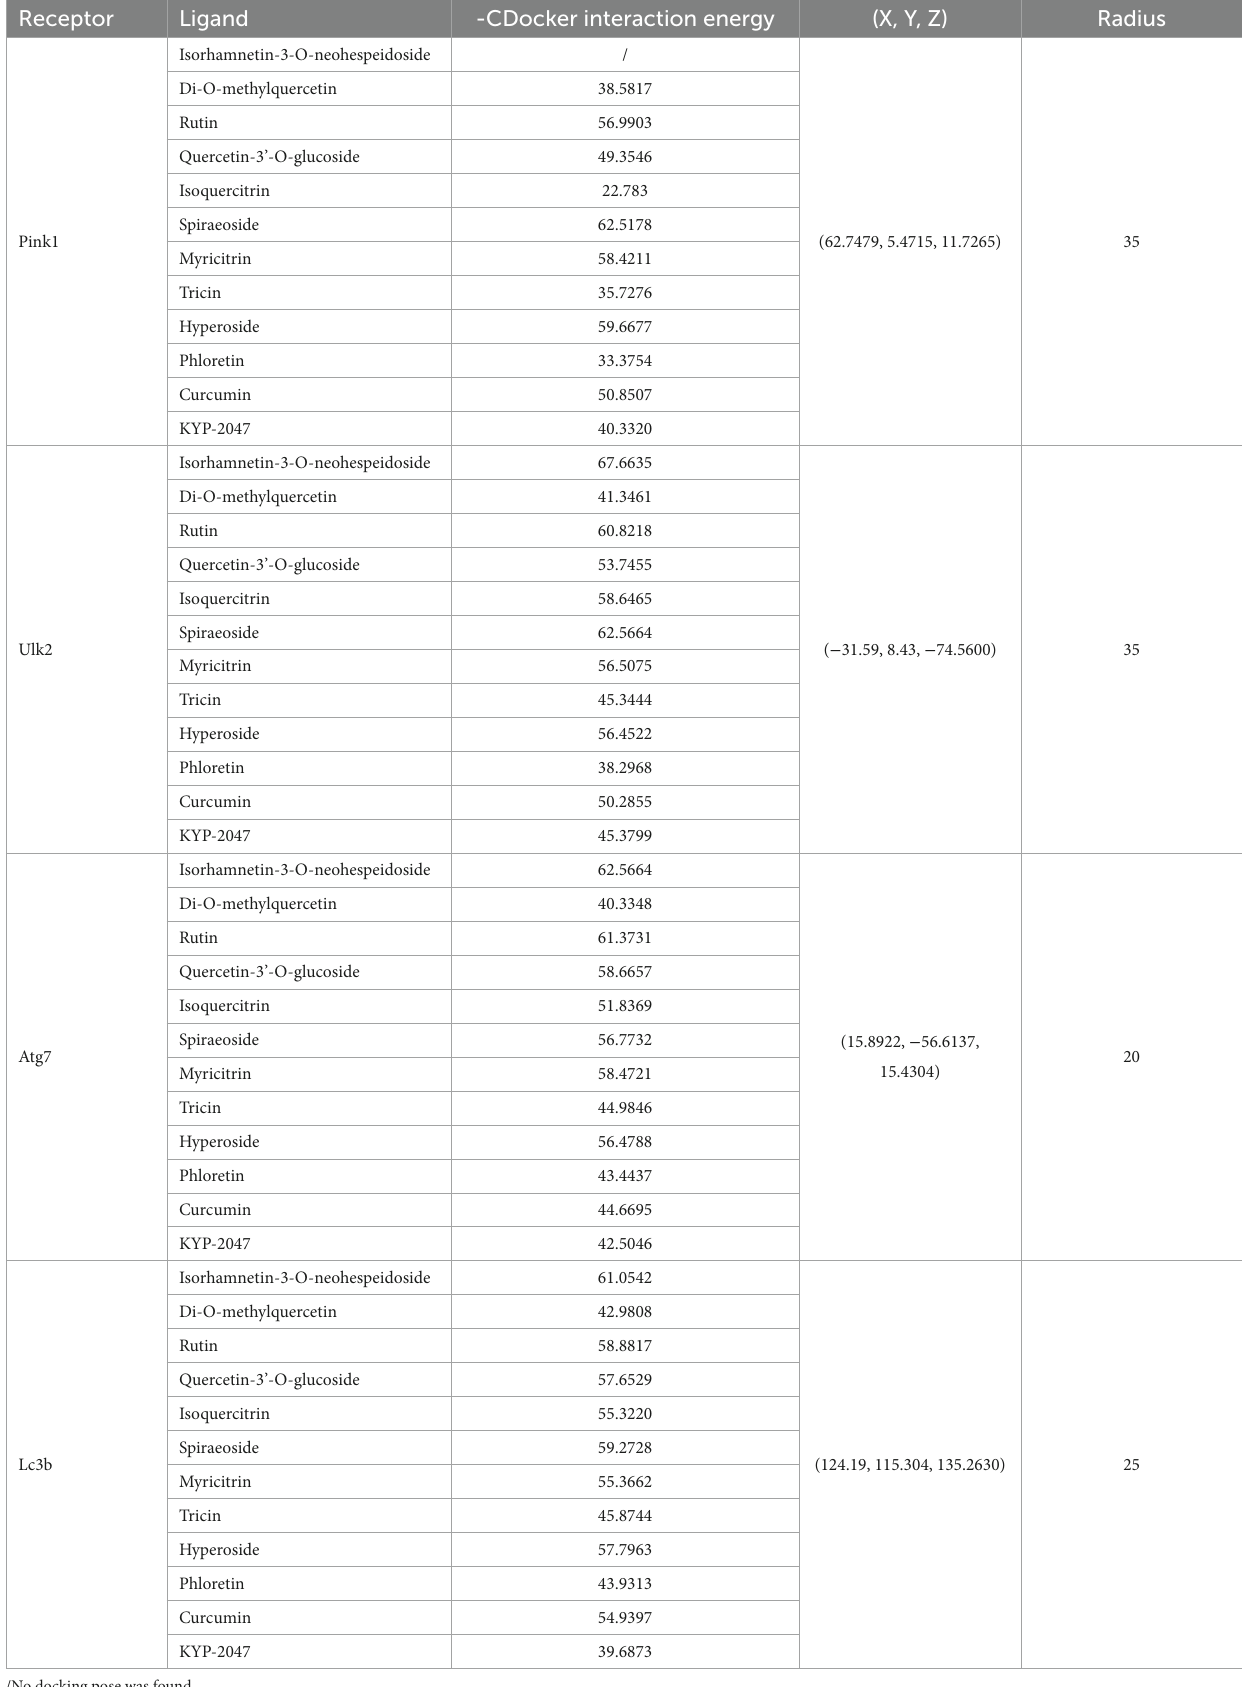
/No docking pose was